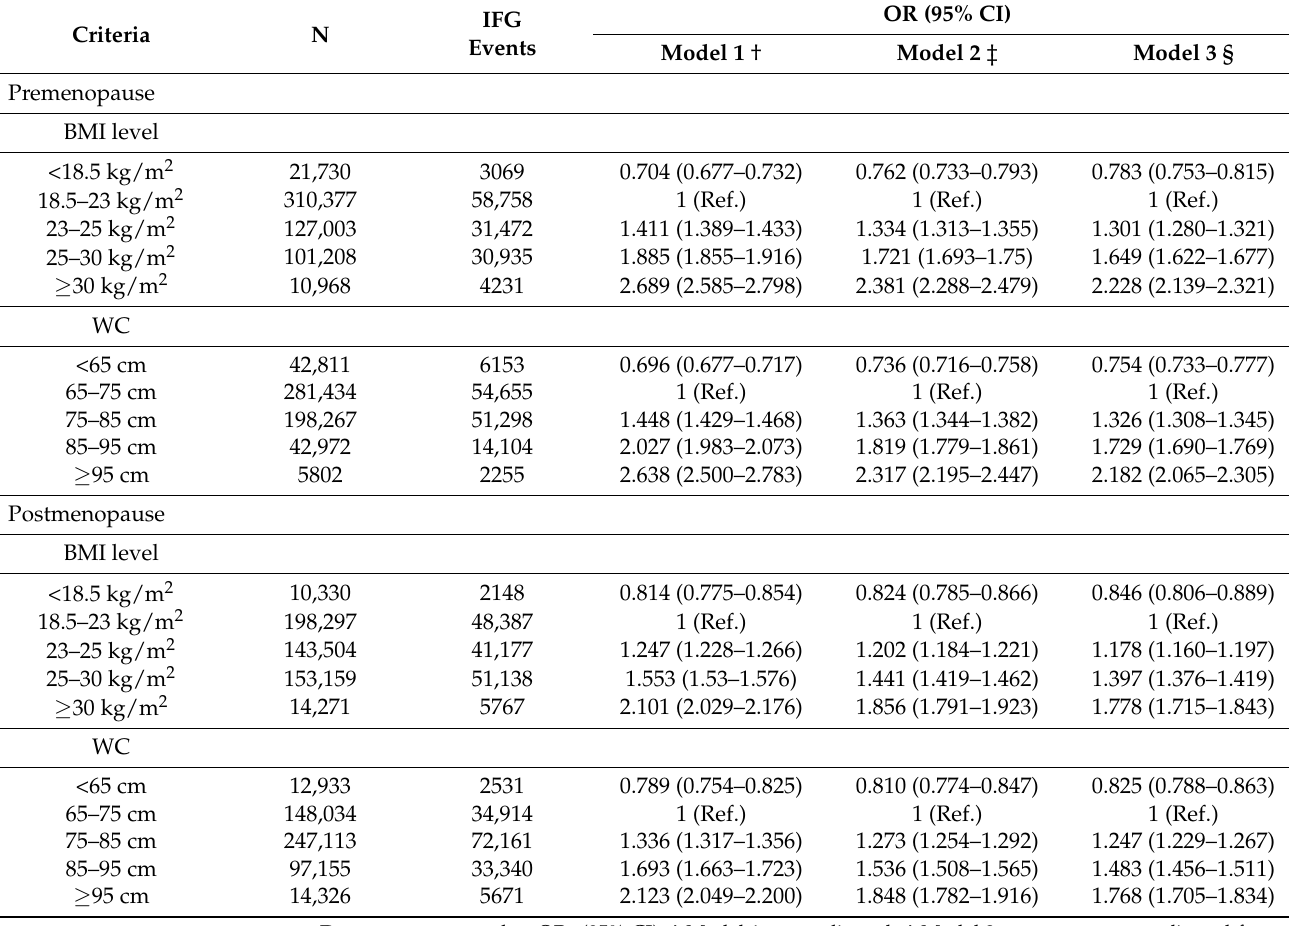
Table 2. Multivariate logistic regression analysis of the association between impaired fasting glucose events and body mass index and waist circumference according to menopausal